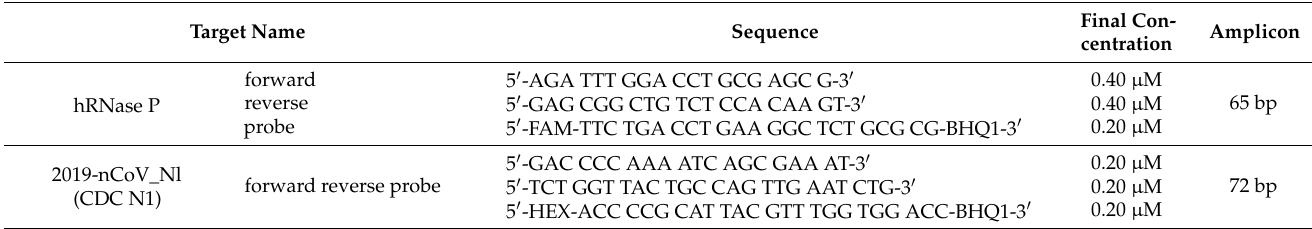
Table 1. PCR primers/probes and control RNA